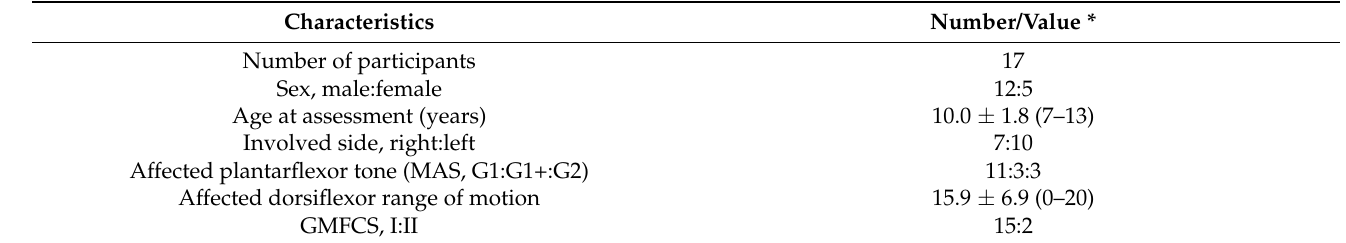
Table 1. Participant characteristics.